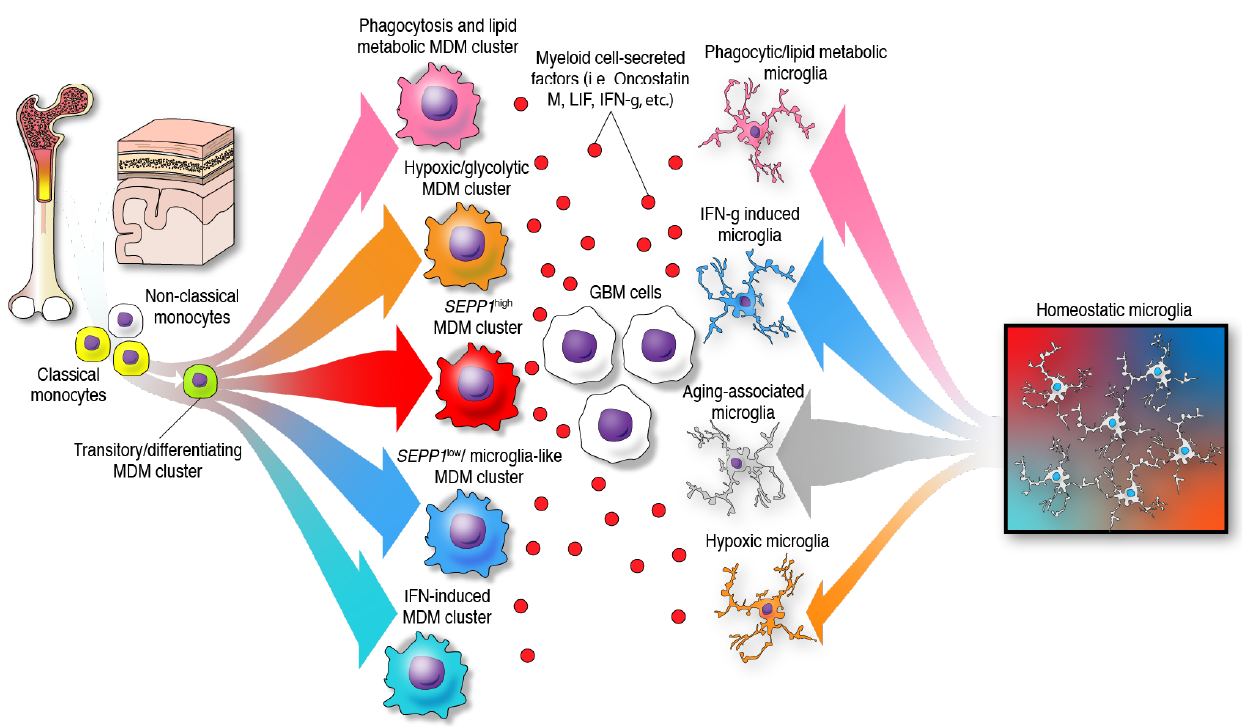
Figure 2. Identity and differentiation trajectories of MDMs and microglia under the influence of GBM cells in the TME. In the presence of gliomas, monocytes and microglia undergo differentiation towards different specific phenotypes.